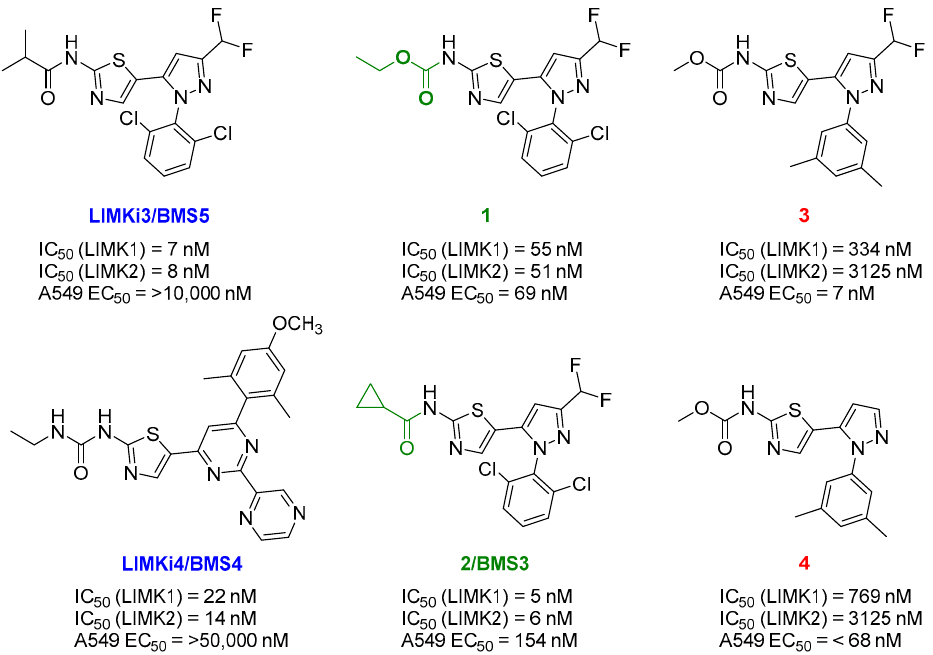
Figure 3. Structure and activity of BMS compounds: selective LIMK inhibitors (blue), cytotoxic LIMK inhibitors (green), and cytotoxic compounds with no LIMK activity (red).